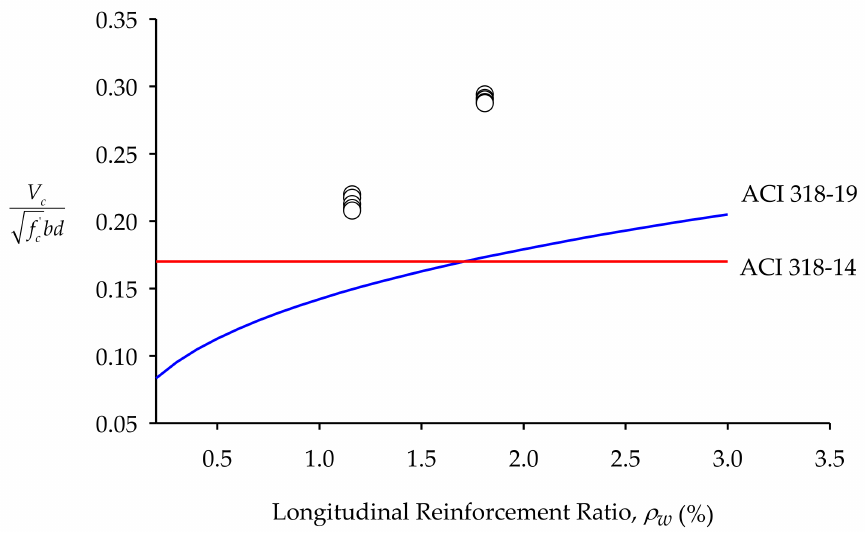
Figure 8. Comparisons of the normalized shear stress from experiments, ACI 318-14, and ACI